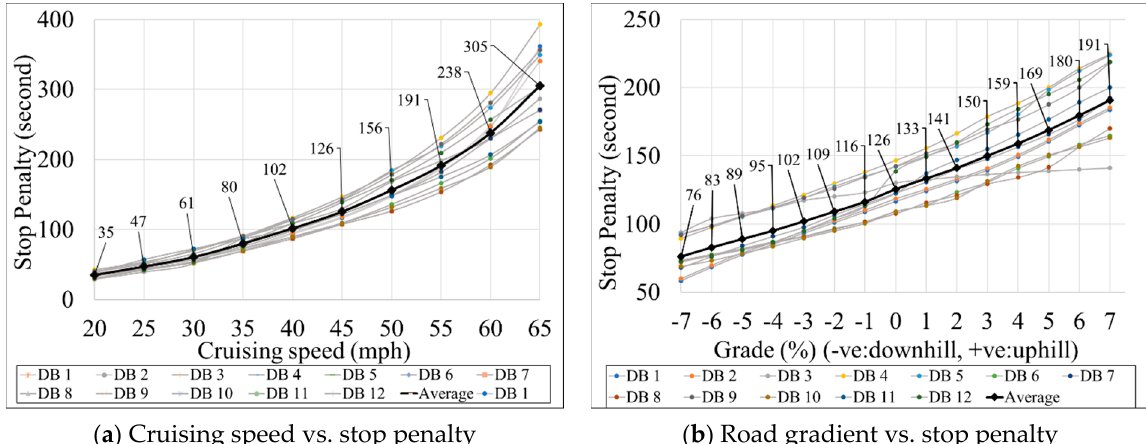
Figure 4. Impact of various speeds, grades, and driving behaviors (DB) on the K -factor